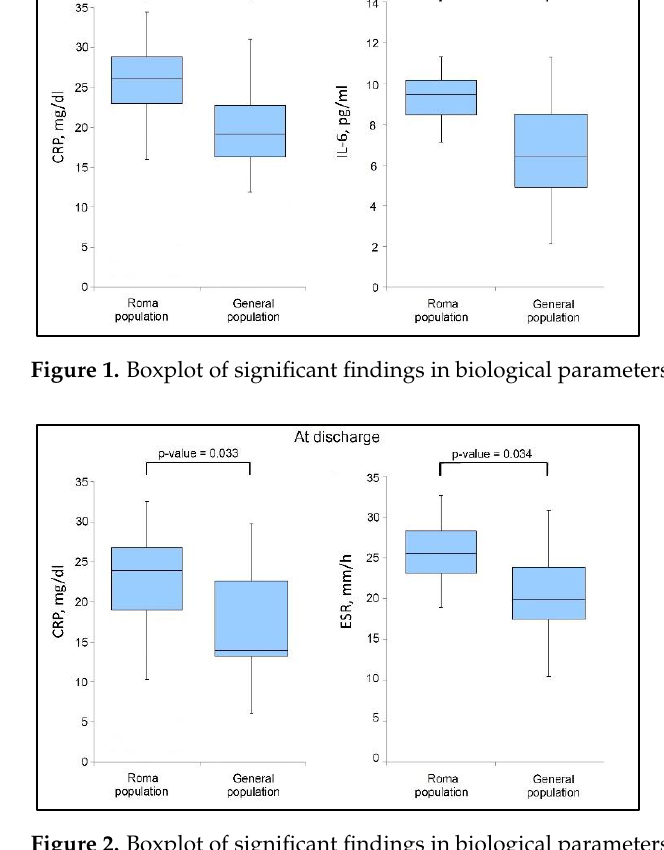
Figure 2. Boxplot of significant findings in biological parameters at discharge. Table 5. Comparison of cytokines and inflammatory markers at discharge between patients of Roma and Romanian ethnicity with severe